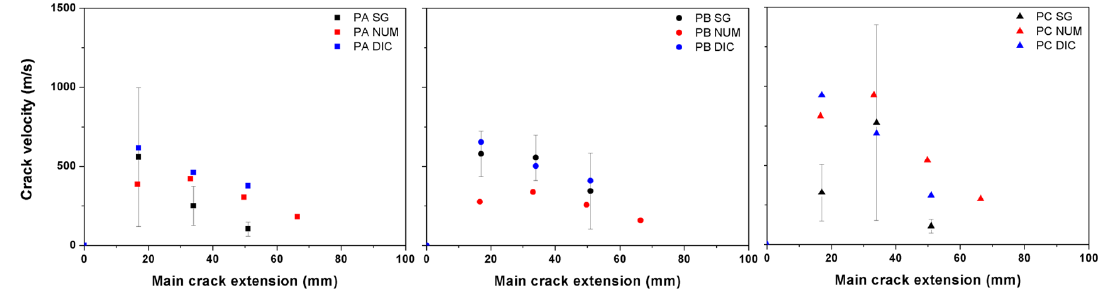
Figure 16. Comparison of the obtained crack velocities using strain gages (SG), digital image Correlation (DIC) and numerical simulations (NUM) for PA, PB and PC beams impacted at 2.66